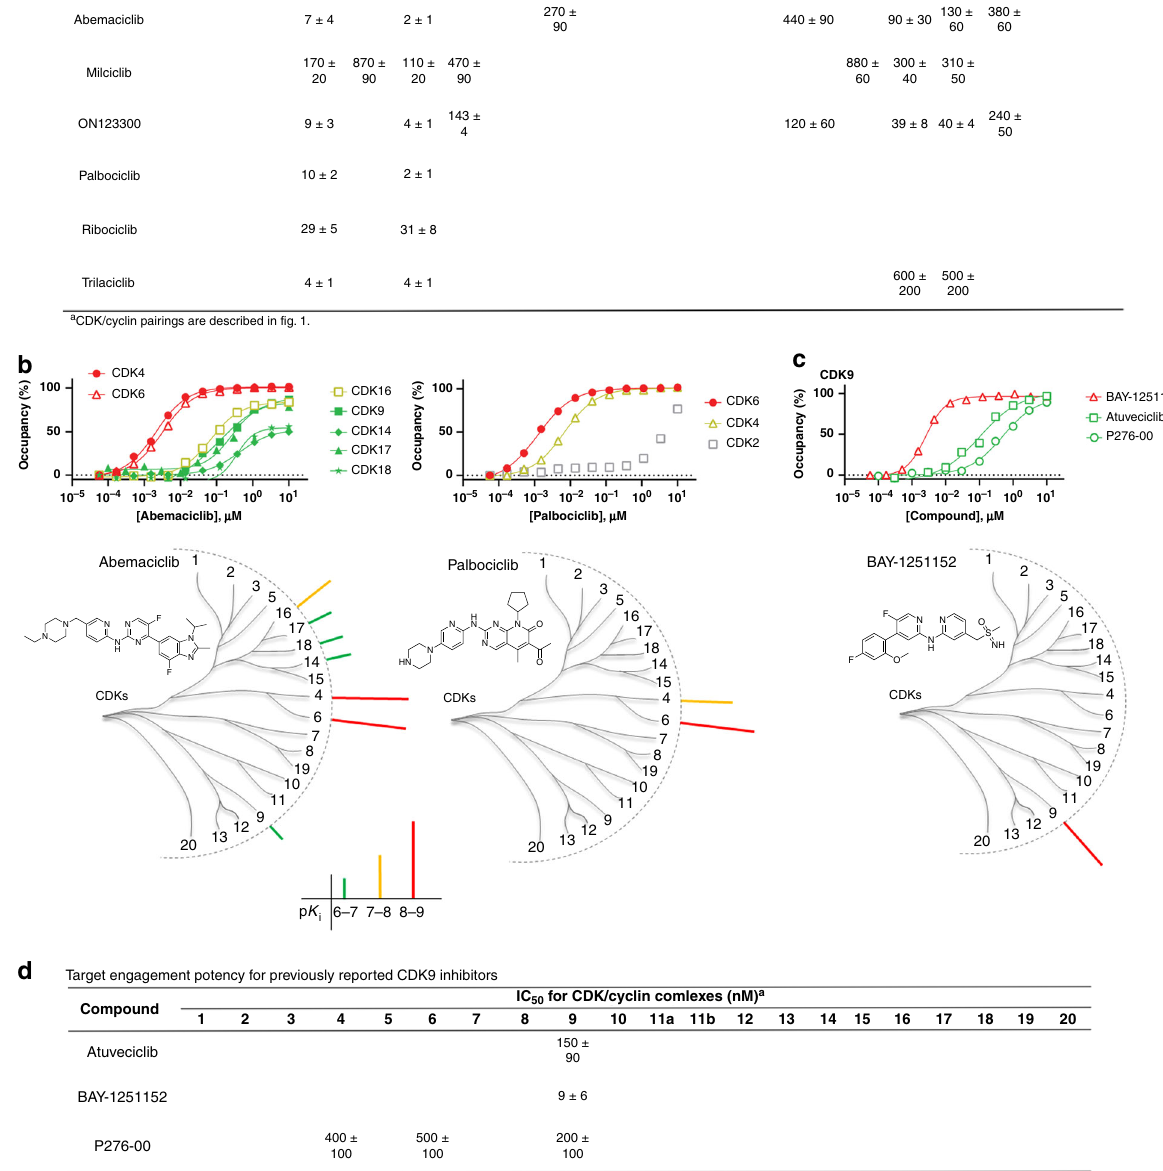
Fig. 2 Selective CDK4/6 and CDK9 inhibitors. a Live cell engagement potency for CDK4/6 selective probes. Reported IC 50 data with values <1 µ M. Blank cells represent IC 50 values that failed to meet our criteria of potency (<1 µ M) or occupancy ( ≥ 50% at 10 µ M). Reported IC 50 data are the mean of 3 independent experiments ± S.E.M. (Supplementary Data 2). b Upper: Target engagement of abemaciclib and palbociclib. A representative single technical replicate ( n = 1) of live cell target occupancy results from 3 independent experiments (Supplementary Data 2). For palbociclib, CDK2 occupancy is included for comparative reference. Lower: Compound structures and dendrogram-based illustration of engagement selectivity for abemaciclib and palbociclib against the complete CDK family. c Upper: Target engagement of CDK9-selective inhibitors. A representative single technical replicate ( n = 1) of target occupancy results from 3 independent experiments (Supplementary Data 2). Lower: Compound structure and dendrogram-based illustration of engagement selectivity for BAY-1251152. d . Engagement potency for CDK9-selective inhibitors. Reported IC 50 data are the mean of 3 independent experiments ± S.E.M. (Supplementary Data 2). Blank cells represent IC 50 values that failed to meet our criteria of potency (<1 µ M) or occupancy ( ≥ 50% at 10 µ M). Source data are provided as a Source Data fi